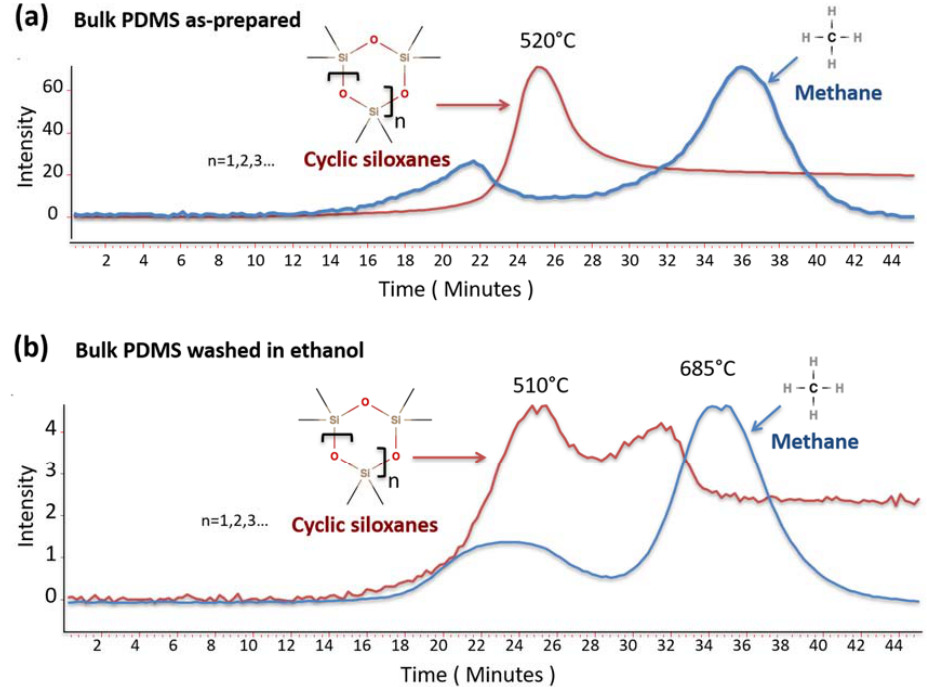
Figure 6. Evolution profiles of CH 4 and cyclic siloxane compounds from the TG/FTIR of bulk PDMS thermal decomposition at 20 °C min under N 2 .